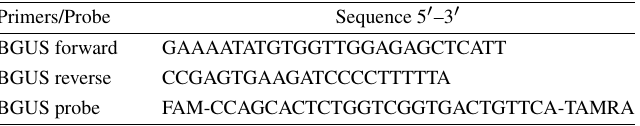
Primers and probes of BGUS used for qRT-PCR